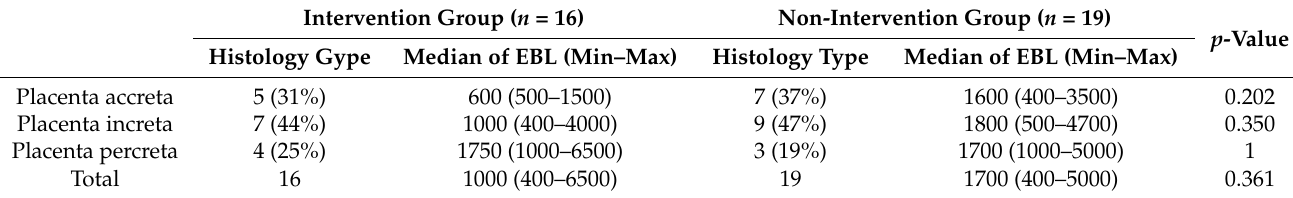
Table 3. Association between placenta histology type and estimated blood loss